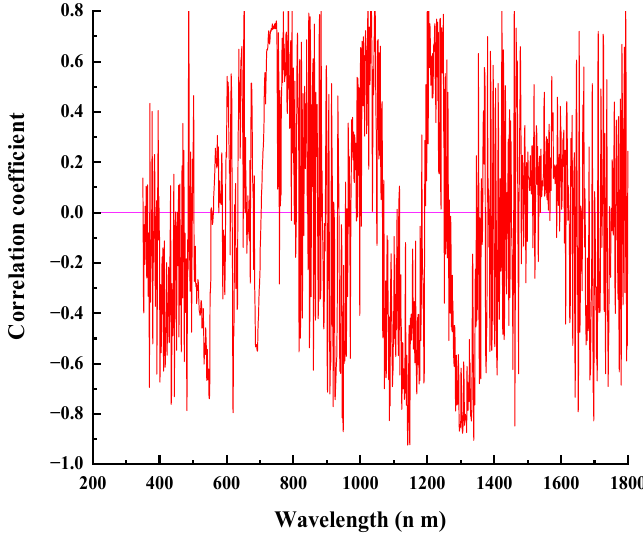
Figure 5. The correlation between the canopy first-order differential spectrum and the leaf area index.